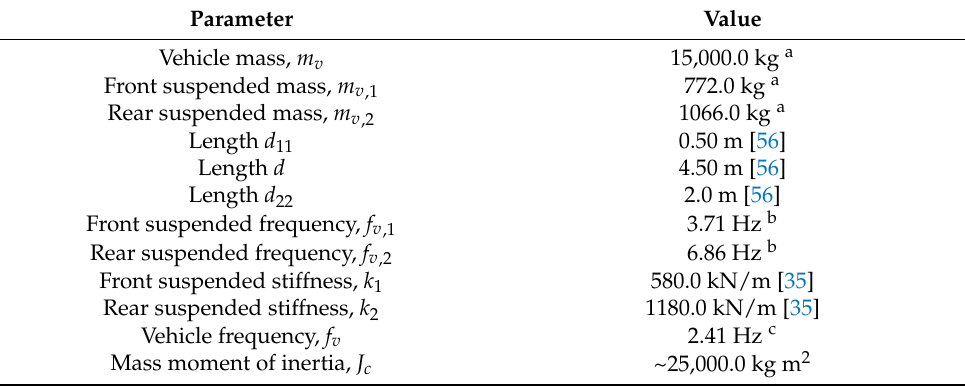
Table 2. The 2C vehicle data.